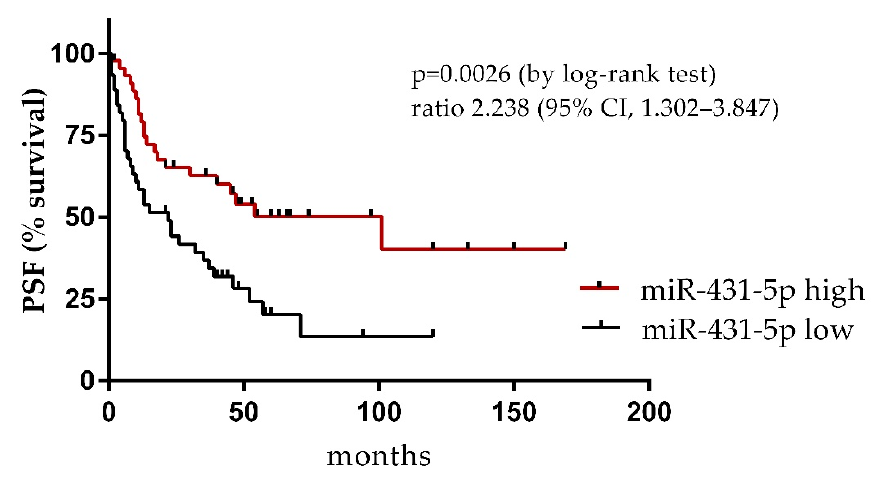
Figure 3. Survival curve (time to progression) according to the circulating miR-431-5p levels in patients with primary VSCC. Abbreviations: PFS, progression-free survival; high and low, high and low miR levels (> and < median normalized level, respectively).